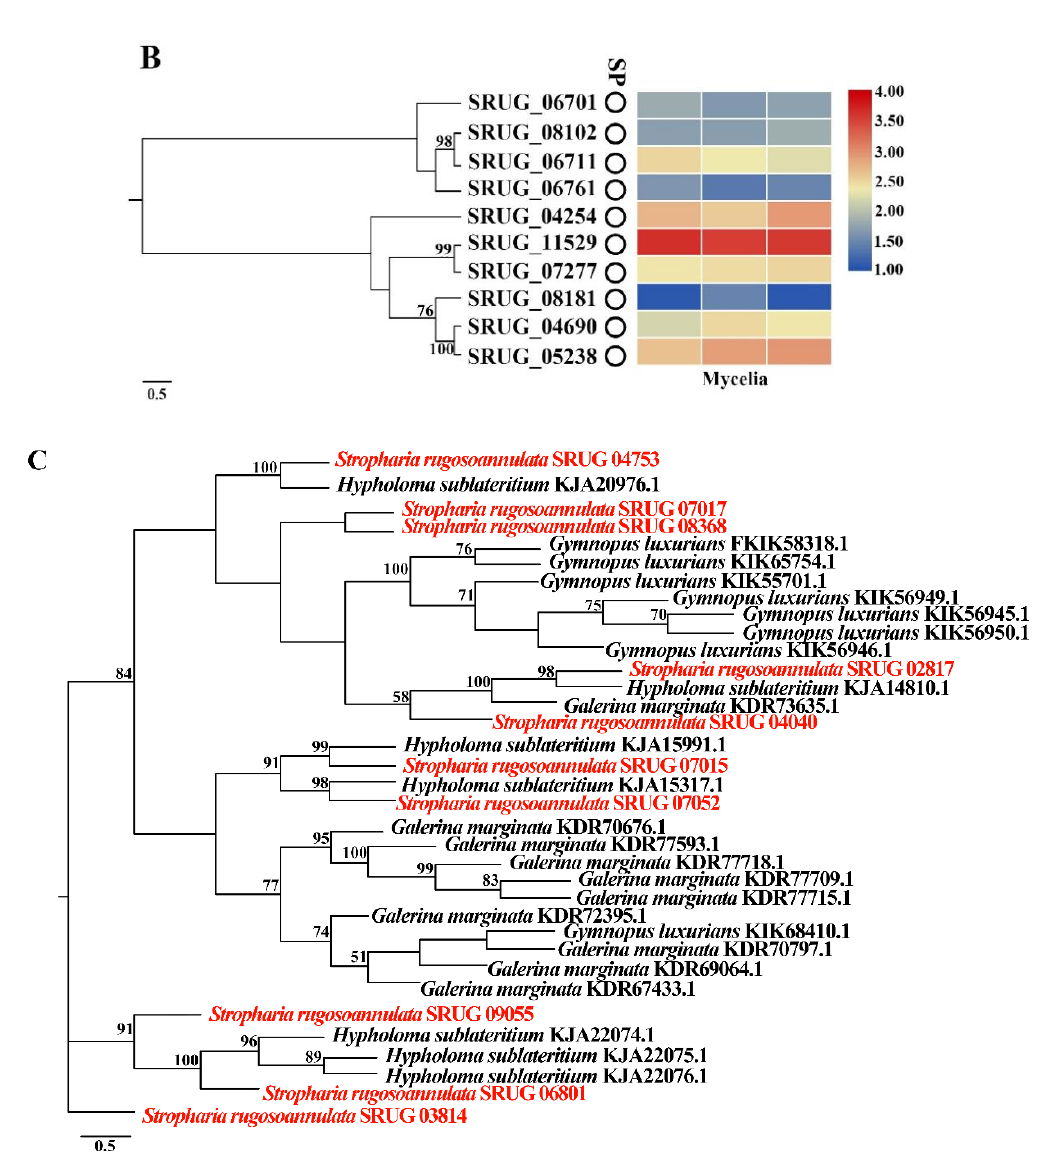
Figure 4. Phylogenetic analysis based on the amino acid sequences of peroxidases and transcription level of the genes ( A ) 50 putative heme peroxidases. ( B ) 10 putative non-heme peroxidases. ( C ) Phy- logenetic analysis of Apx–CcPs from the species of S. rugosoannulata , H. sublateritium , G. marginata, and G. luxurians . The phylogenetic trees were constructed using RAxML (version 8) with 1000 boot- strap replicates. The numbers at the nodes represent the bootstrap percentages. The solid black and empty circles represent the secreted and non-secreted proteins, separately. A heatmap drawn with TBtools [43] indicated the expression in the mycelia of S. rugosoannulata . HTP, heme-thiolate perox- idases, APx–Ccp, hybrid ascorbate-cytochrome c peroxidases, and Nox, NADPH oxidase genes. The red fonts in ( C ) indicated the Apx–CcPs from S. rugosoannulata.